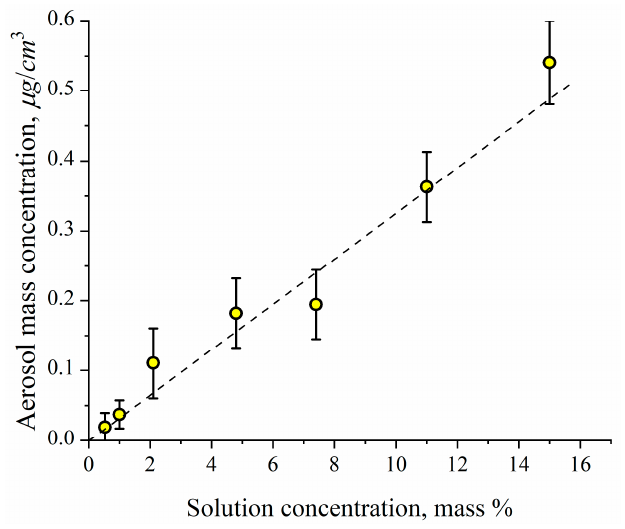
Figure 5. Aerosol mass concentration as measured at the outlet of aerosol generator vs. ceftriaxone concentration in the nebulizing solution. Dashed line is an eye guide.